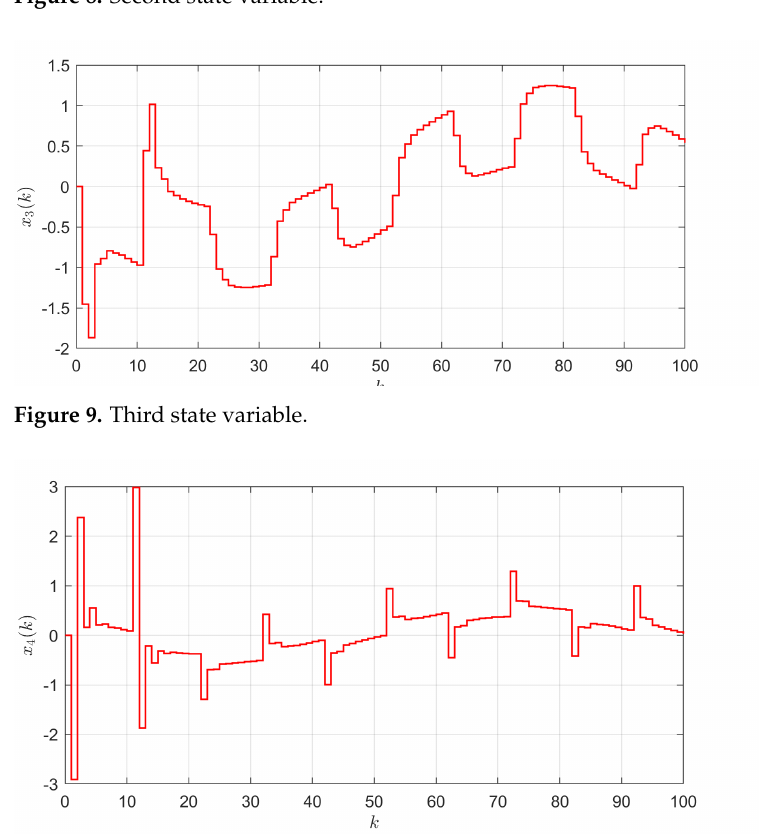
Figure 10. Fourth state